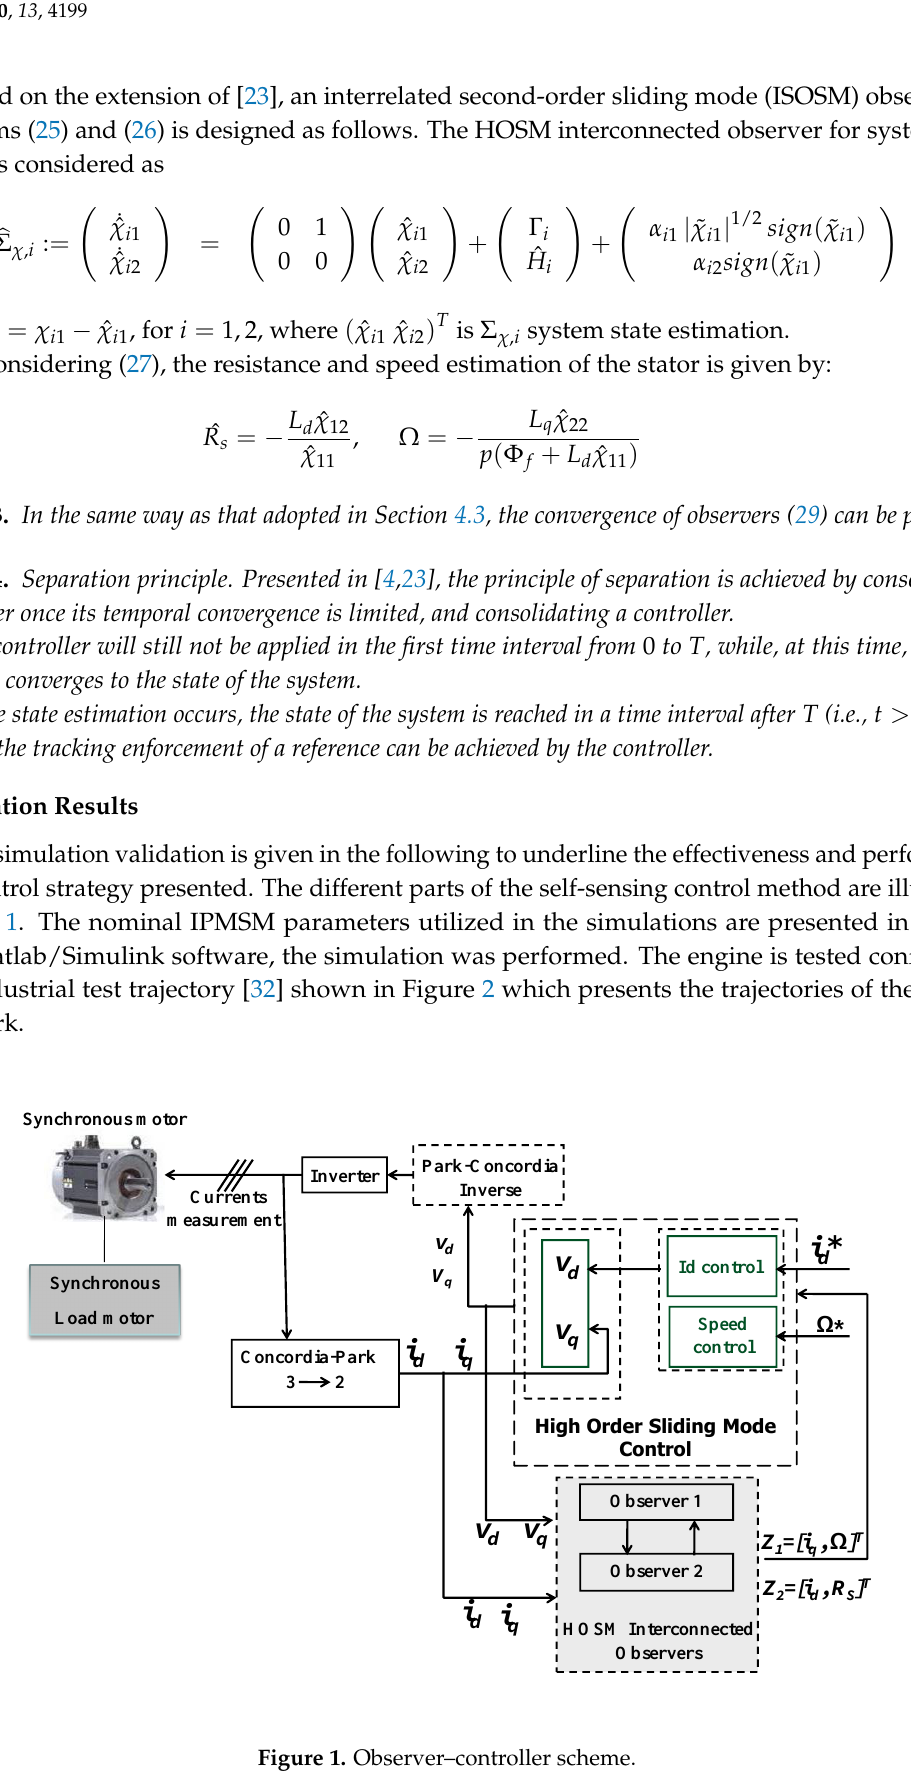
Figure 1. Observer–controller